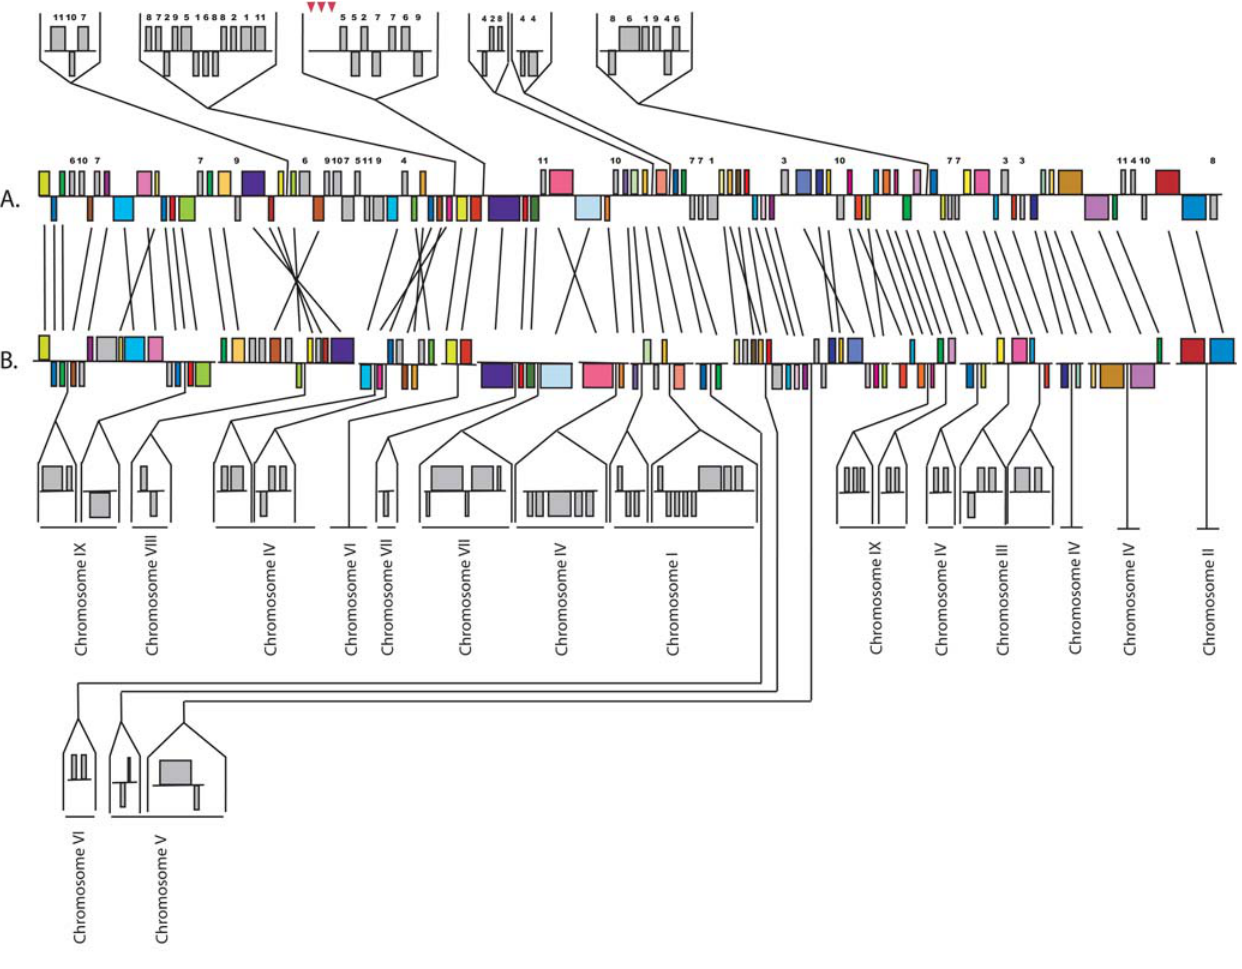
Figure 3. Analysis of contigs included in the scaffold SC_2496 and gene order comparisons between the E.bieneusi(A) and E.cuniculi(B) orthologues.